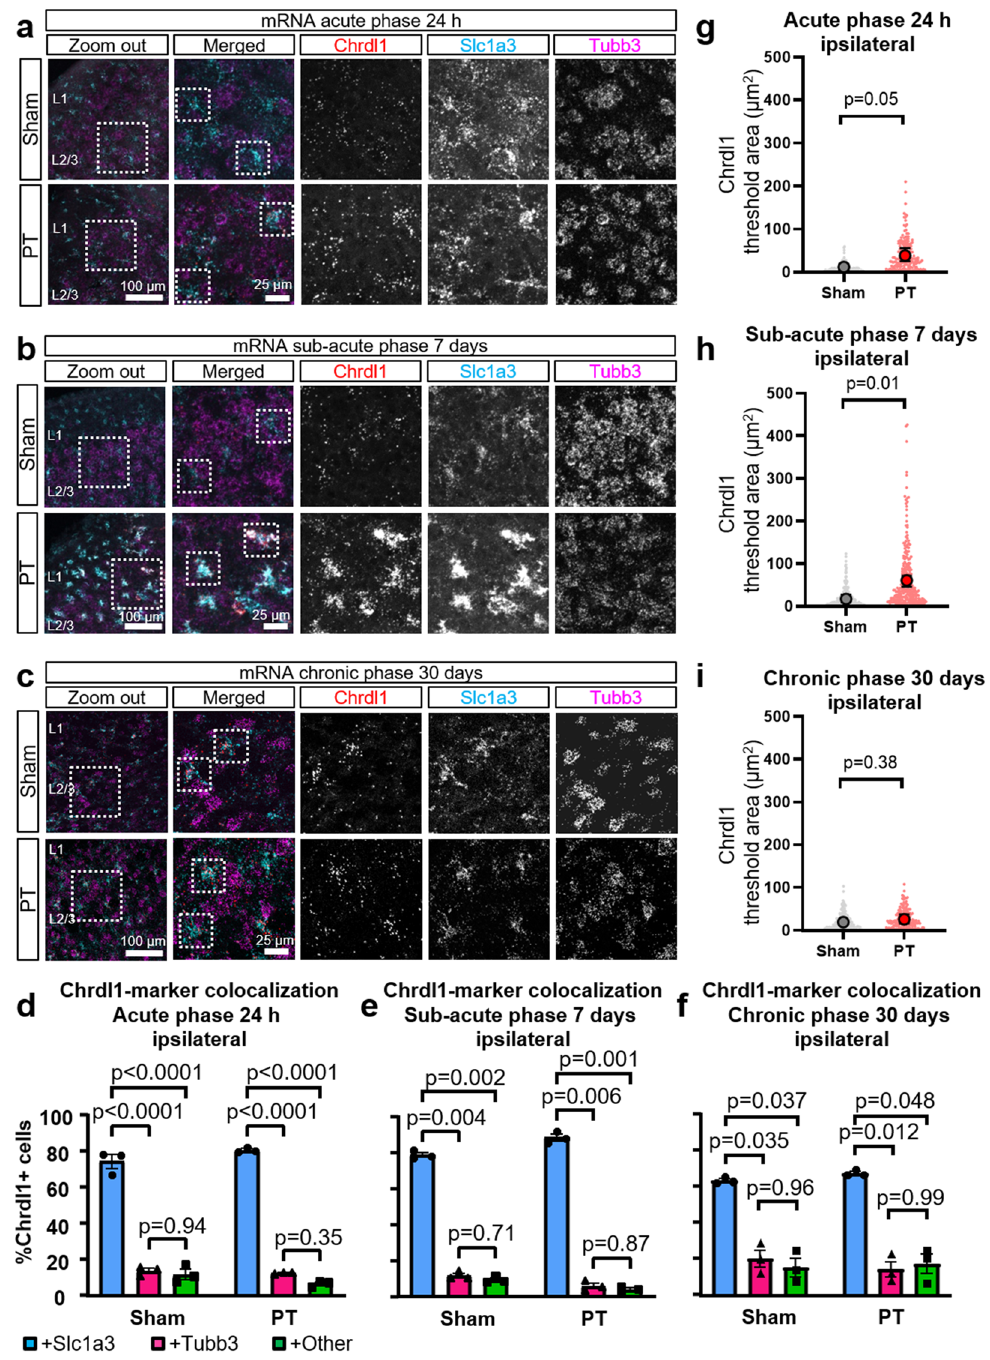
Figure 2. Astrocytes are the main cells expressing Chrdl1 in the peri-infarct area. ( a ) Representative images of coronal sections of the peri-infarct area in the visual cortex of WT mice 24 h after PT or sham surgeries. The zoom-out image indicates the ROI that was analyzed (scale bar 100 µm), and the dashed box shows the zoomed-in layers 2/3. FISH of Chrdl1 (in red), Slc1a3 (GLAST, in cyan), and Tubb3 (in magenta) in the peri-infarct area (ipsilateral hemisphere). Boxes in the merged image (scale bar 25 µm), indicate examples of astrocytes showing overlapping of Slc1a3 and Chrdl1. ( b , c ) Same as ( a ), but in WT mice 7 days and 30 days after PT or sham surgeries, respectively. ( d ) Quantification at 24 h after PT of overlapping signal between Chrdl1 and Slc1a3 (astrocyte marker), or Chrdl1 and Tubb3 (neuronal marker), or Chrdl1 and other cells. Sham N = 3, PT N = 3 mice. ( e , f ) Same as ( c ) but 7 days and 30 days after PT or sham surgeries, respectively. Sham N = 3, PT N = 3 mice both timepoints. Statistics by two-way ANOVA. ( g – i ) Scatter plots represent quantification of threshold area of Chrdl1 in single astrocytes at each time point (24 h, 7 days, and 30 days after PT). Mean ± range is represented. Sham N = 3, PT N = 3 mice per time point. Statistics by unpaired